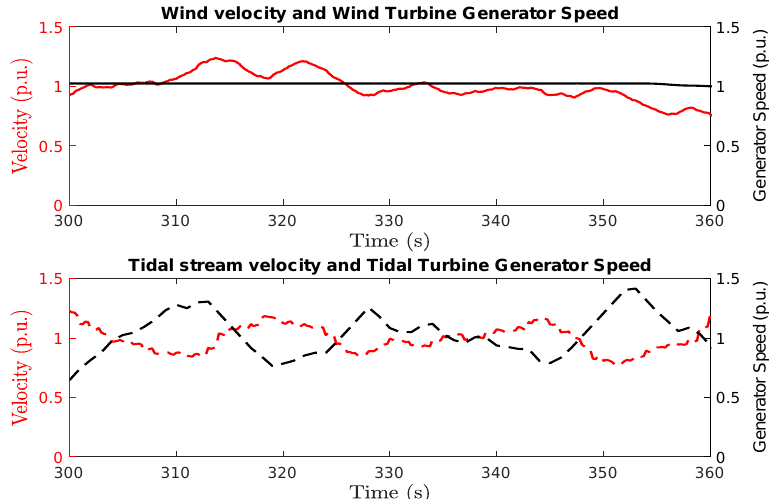
Figure 17. Comparison of generator speed fluctuations in a 10 MW wind turbine and a 110 kW tidal